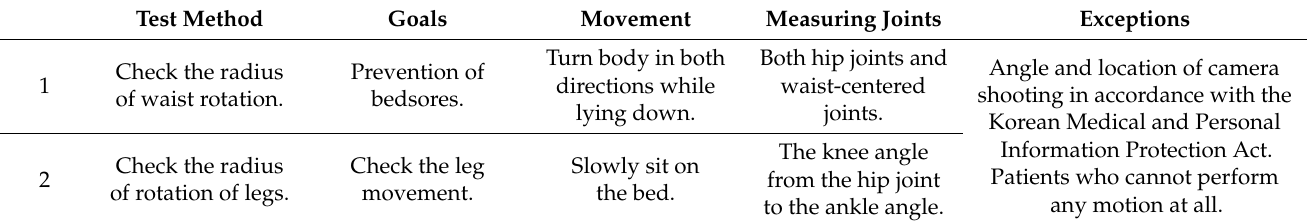
Table 3. How to perform the